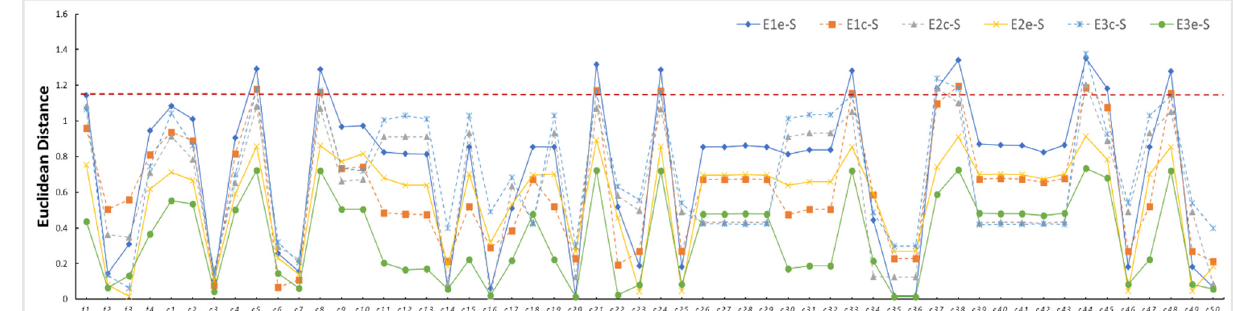
Figure 5. Euclidean distances between the eddies and seawater under the CP feature of data #A. The y -axis is the Euclidean distance, and the x -axis indicates the features ( f 1 –f 4 are σ HH , σ HV , σ VH , and σ VV , respectively, while c 1 –c 50 are the corresponding features shown in Table 2). Among them, E1e-S , E1e-S , and E1e-S are the Euclidean distances between the edge regions and seawater for eddies E-1 , E-2 , and E-3 , respectively, while E1c-S , E1c-S , and E1c-S are the Euclidean distances between the eddy center region and seawater, and the red dashed line indicates the Euclidean distance values between the eddies and the ocean background in the σ HH image.